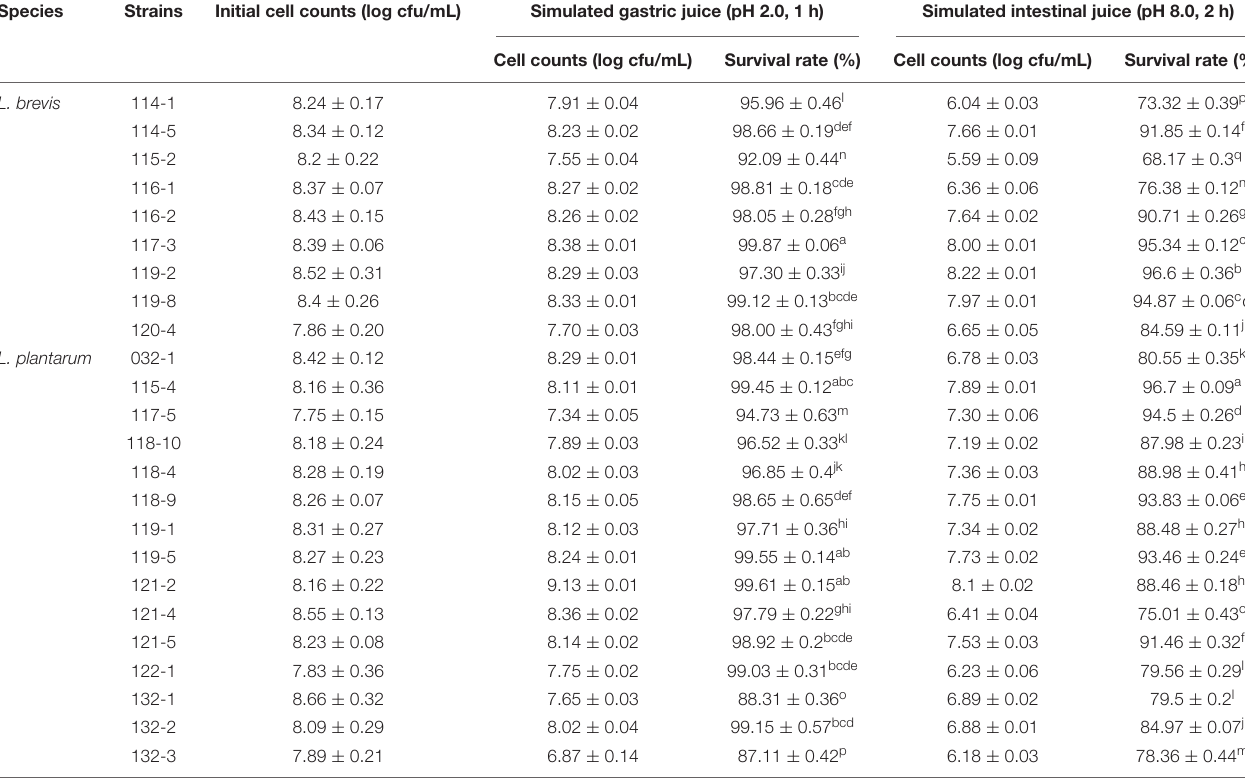
TABLE 2 | In vitro resistance to simulated gastrointestinal juice of Lactobacillus strains from fermented vegetables in Shaanxi, China. Species Strains